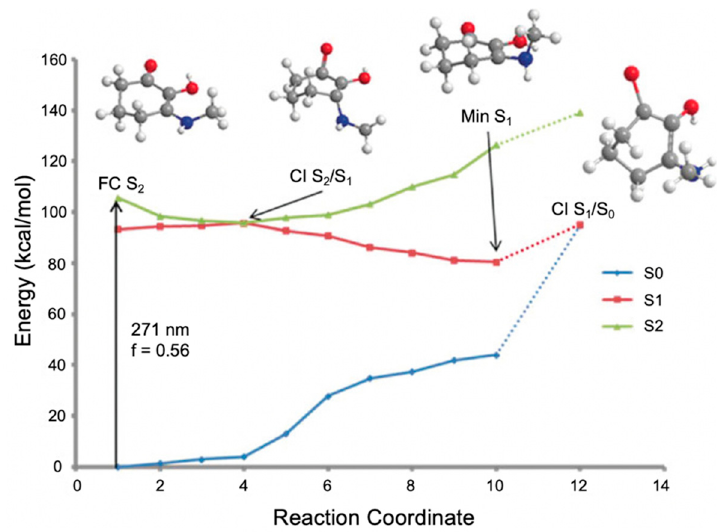
Figure 11. Computed minimum energy path (MEP) of molecule 1 by Losantos et al. [89] where f is the oscillator strength. Reproduced and adapted with permission from [89]. © 2017 Wiley-VCH Verlag GmbH & Co. KGaA, Weinheim.